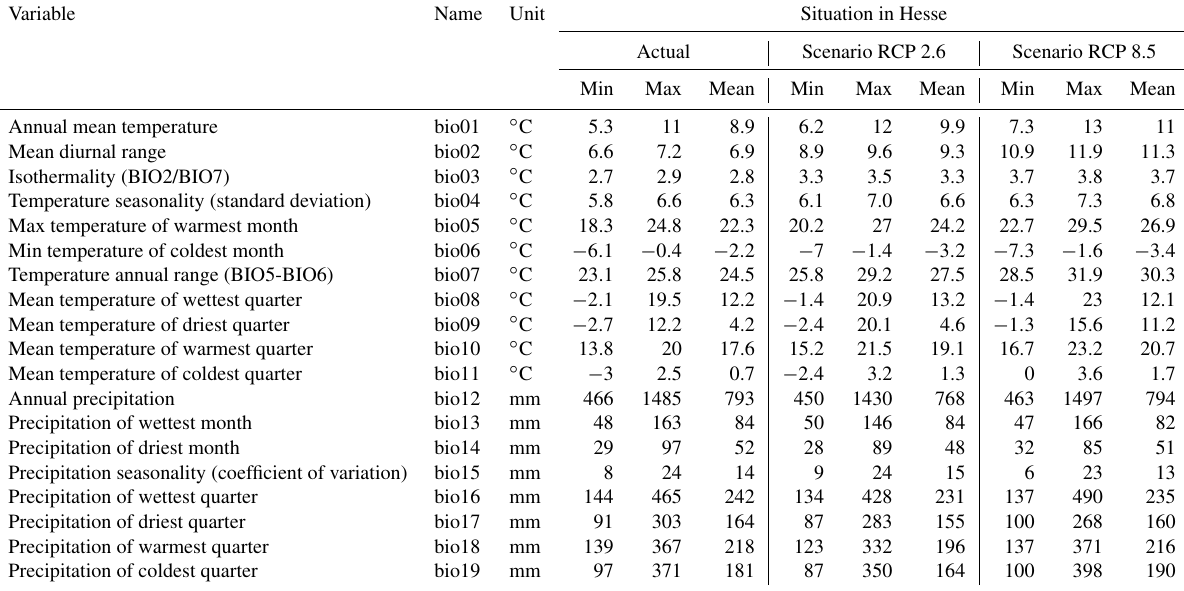
Table 1. Bioclimatic variables of the CHELSA database (http://chelsa-climate.org/, last access: 24 May 2019), the situation under current conditions, and the values for Hesse according to scenarios RCP 2.6 and RCP 8.5. Each value was calculated on the basis of 80204 grid cells for Hesse. One cell measures approx. 600m ×